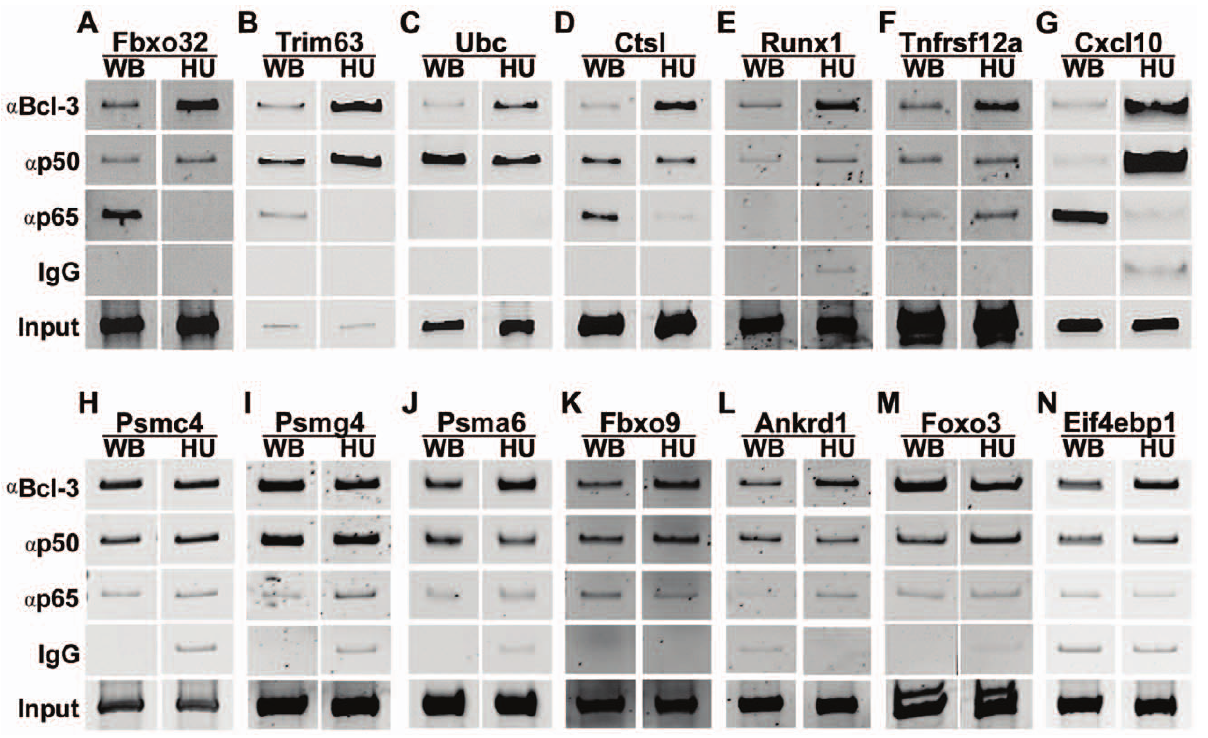
Figure 2. ChIP assays of Bcl-3, p50, and p65 protein binding to genes from Figure 1. ChIP assay was performed using gastrocnemius/ plantaris muscle from weight bearing (WB) and unloaded (HU) mice. For each gene shown, binding of Bcl-3, p50 and p65 protein to a k B binding site was measured. ChIP showed an increase in Bcl-3 protein binding to 7 of the 14 genes studied, these were: A ) Fbxo32 , B ) Trim63 , C ) Ubc , D ) Ctsl , E ) Runx1 , F ) Tnfrsf12a , and G ) Cxcl10 . There were also increases in p50 ( B, E, G ) and decreases in p65 ( A, B, D, G ) in these 7 genes. None of the proteasomal subunit genes showed changes in Bcl-3, p50, or p65 binding, Psmc4 ., Psmg4 , or Psma6 ( H–J ). Fbxo9 , Ankrd1 , Foxo3 , and Eif4ebp1 ( K–N ) genes also did not show changes in the binding of these proteins to k B sites. For each gene, ChIP assays were repeated using different samples from WB and HU groups. The PCR product size for all 14 ChIP assays performed was between 190 to 400bp.